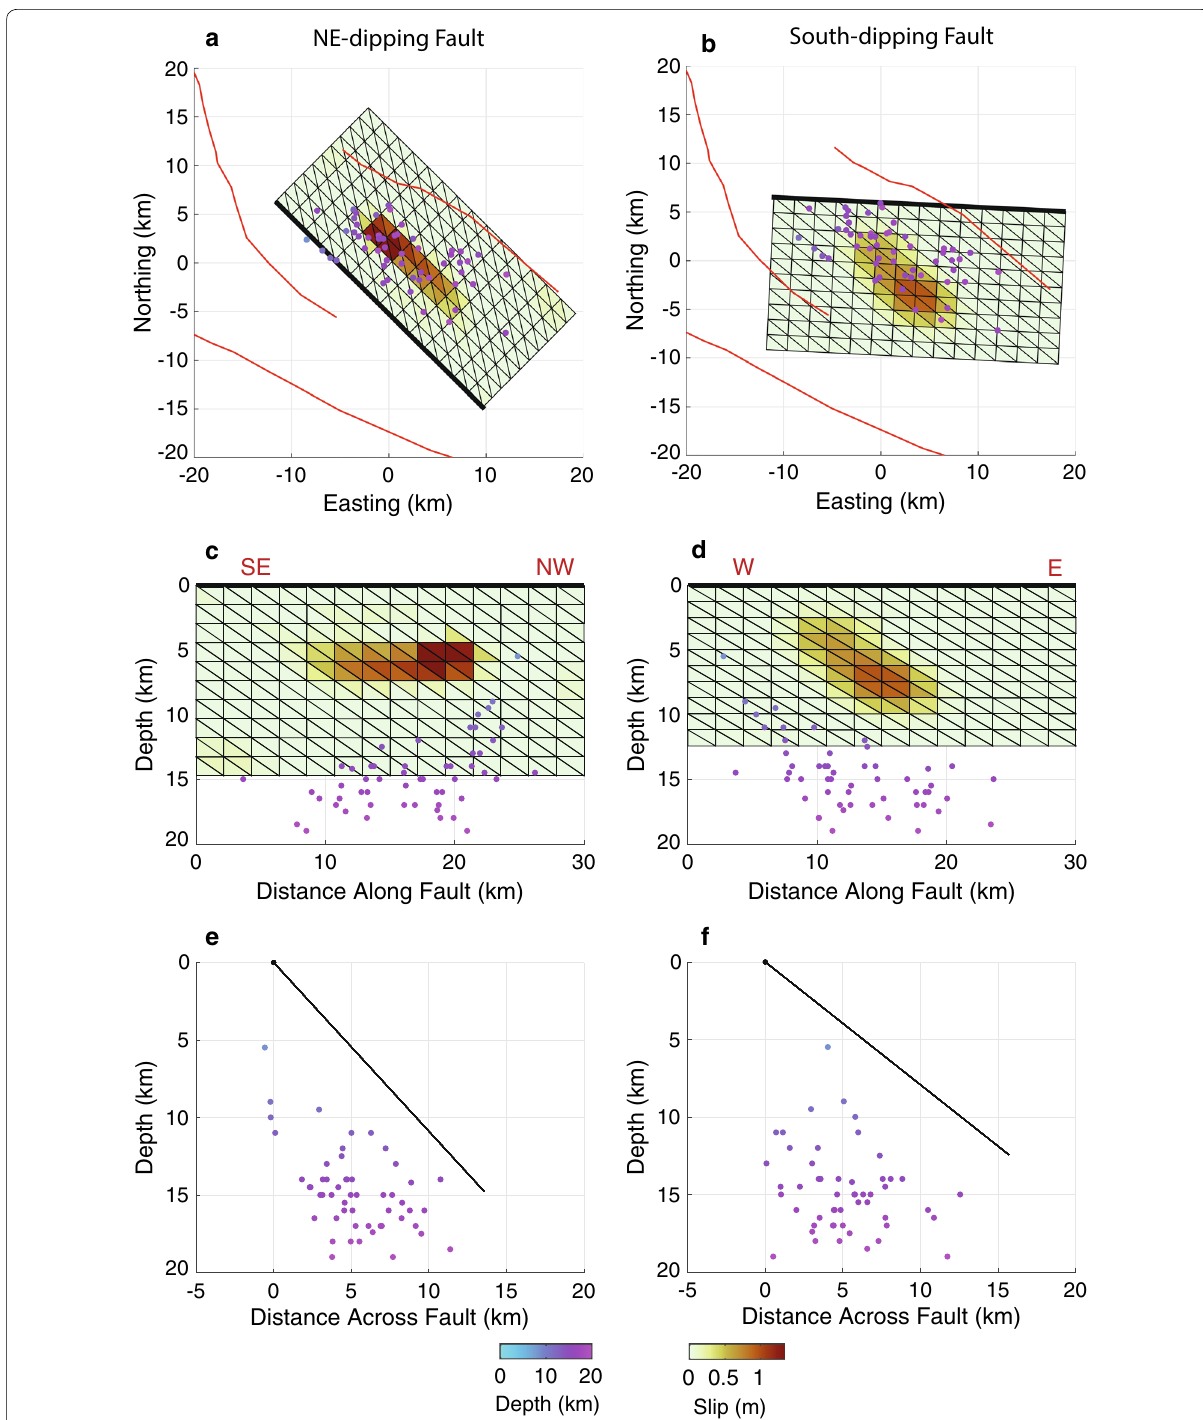
Fig. 6 Fault geometry and slip distribution obtained by two inversions assuming opposing dipping directions. a , c , e NE-dipping fault model. b , d , f South-dipping fault model. The colored dots represent 53 aftershocks relocated by Aflaki et al. (2019). The black thick line indicates top line of the fault. a , b Map view, c , d horizontal view and e , f profile across the